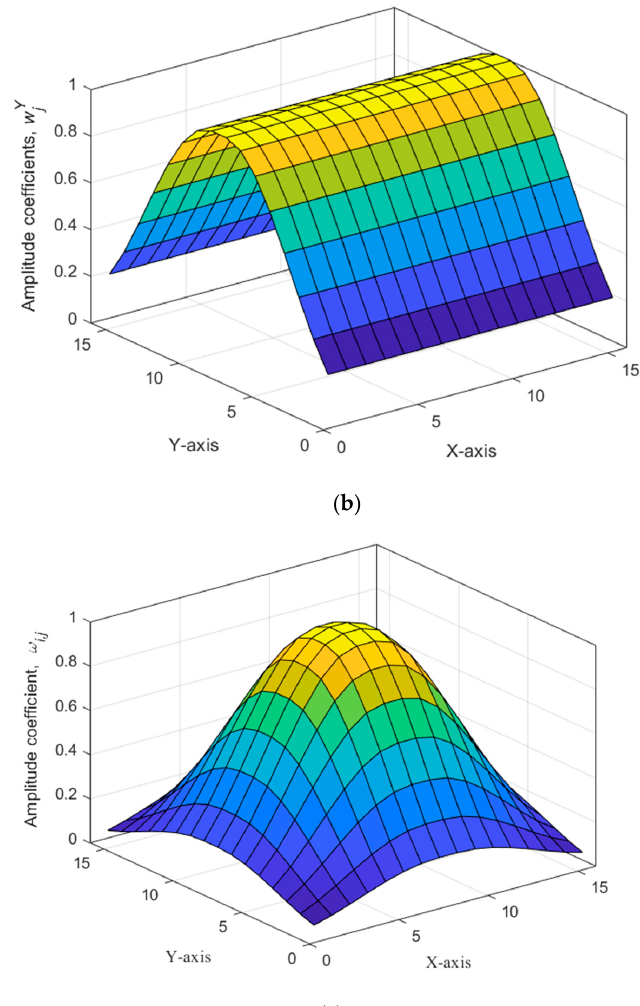
Figure 2 . ( a ) Hamming window for linear arrays along X-direction, ( b ) Hamming window for linear arrays along Y-direction, ( c ) 2D extrapolated Hamming window for 16 × 16 array using cross-linear tapering of weights in ( a , b ).